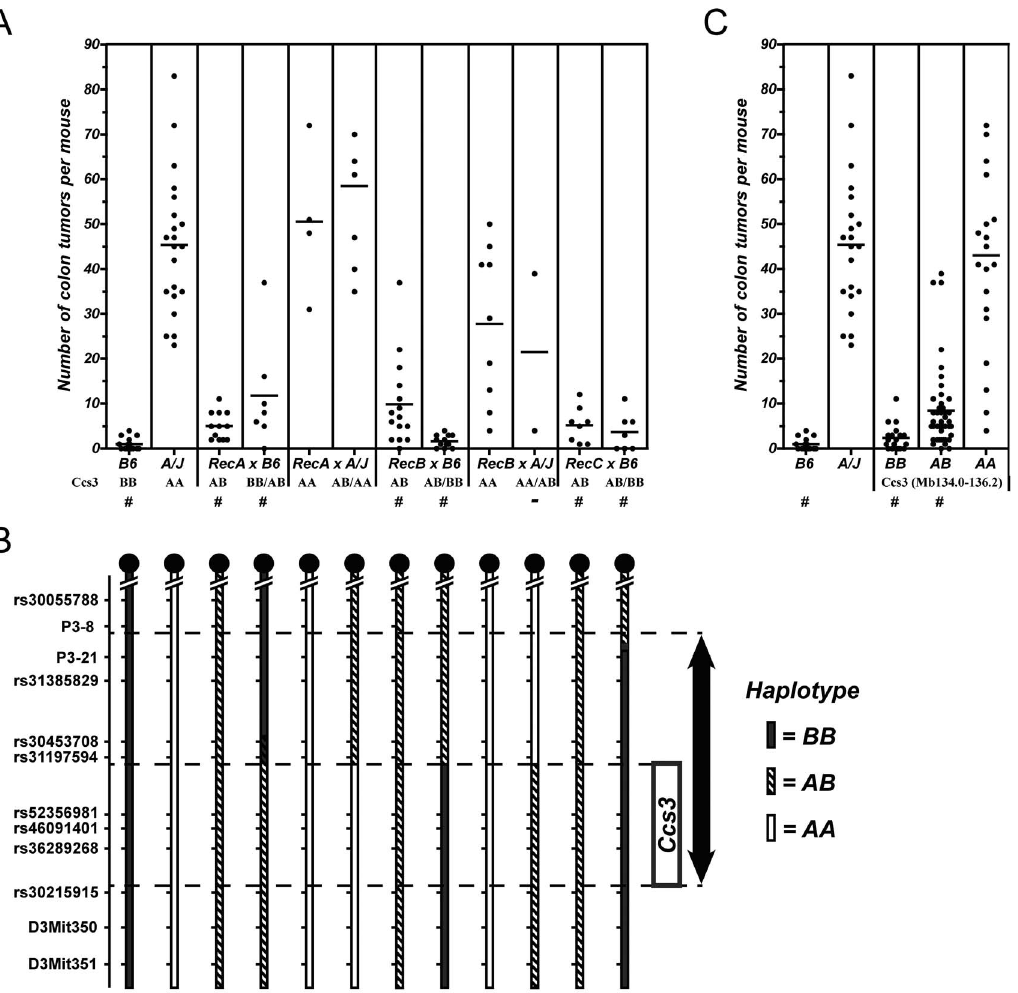
N Figure 2. High resolution genetic mapping of the Ccs3 locus in informative recombinant backcross mice. A. Following AOM treatment, ’). Controls and backcross mice corresponding to key colons were dissected, fixed and the number of tumors was scored (individual mice shown as ‘ recombinants (Rec A, Rec B and Rec C) where bred to A/J (indicated A) and C57BL6/J (indicated as B). Mice were grouped by haplotype at the Ccs3 locus and recombinant animals carry a different haplotype on each half of the Ccs3 interval. Groups showing tumor numbers statistically different form the A parental group are identified ( # ). B . The Ccs3 haplotype on distal chromosome 3 of each group of mice phenotyped in panel (A) is shown in black (B6), white (A/J) or striped (heterozygotes). Dashed lines show the interval first identified in RCS (arrow) as well as the reduced genetic interval for Ccs3 suggested by a recombination event in Rec A and Rec B between markers rs31197594 and rs52356981, on the proximal side (box). The distal boundary was estimated from studies in recombinant congenic strains from Figure 1B. C . Aggregate genotype/phenotype correlation of pooled backcross mice for the reduced Ccs3 interval (Mb134.0–136.2).